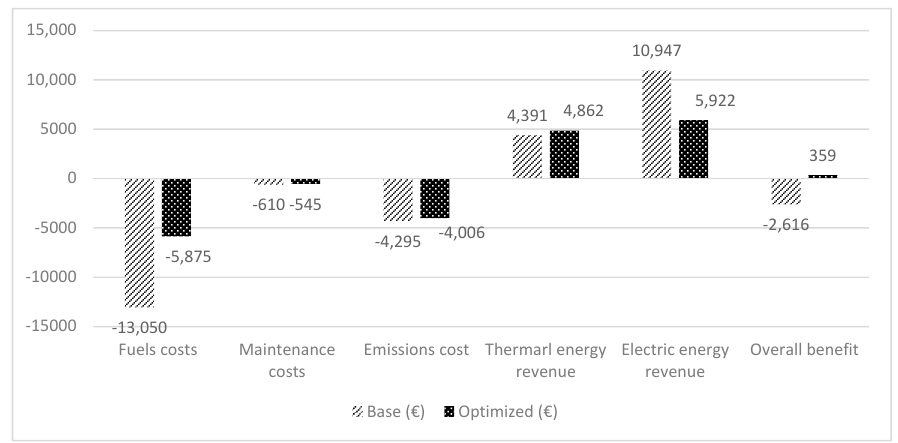
Figure 14. Comparative break down of the base and optimized benefits.